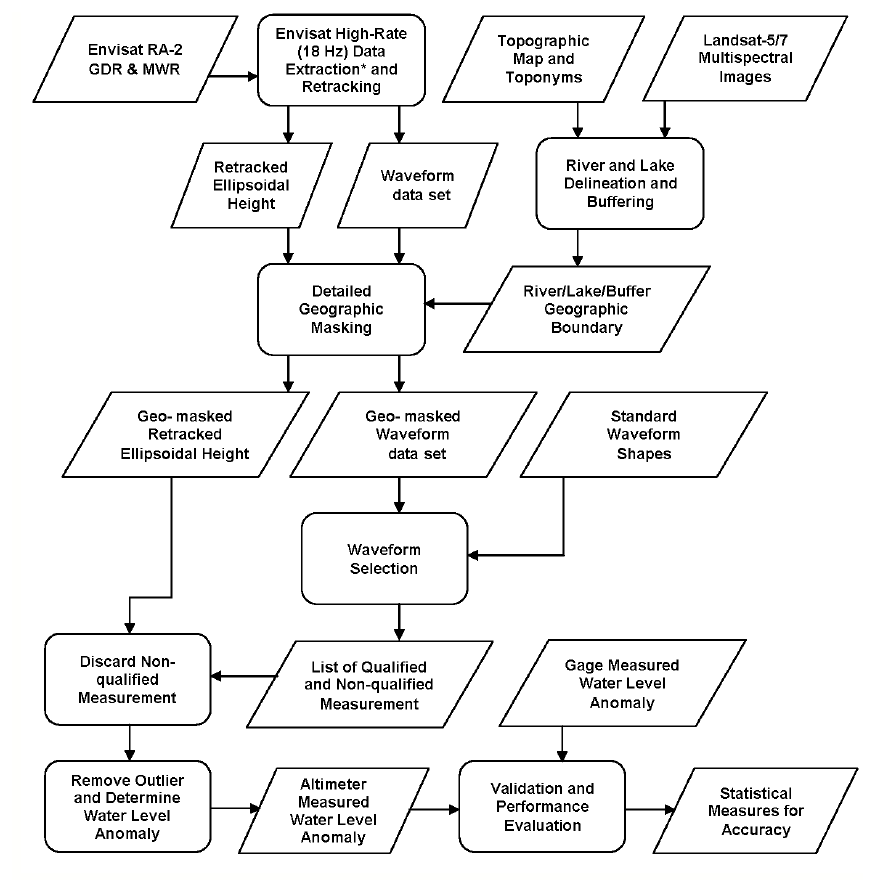
Figure 4. Data processing